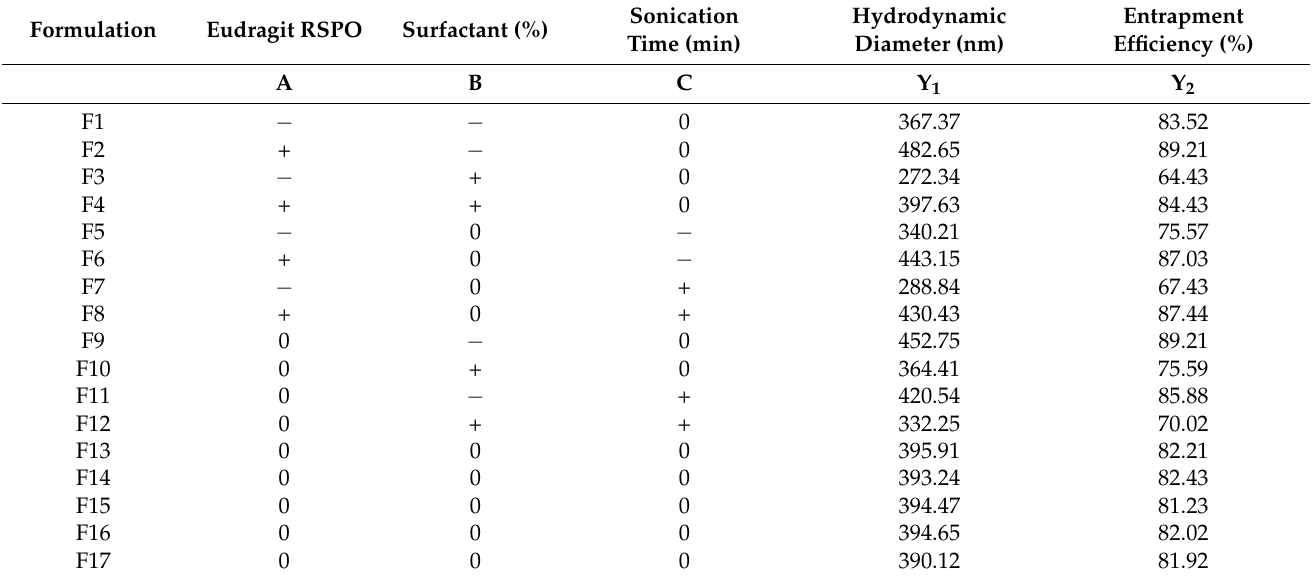
Formulation composition of ALG-NPs and their hydrodynamic diameter and entrapment